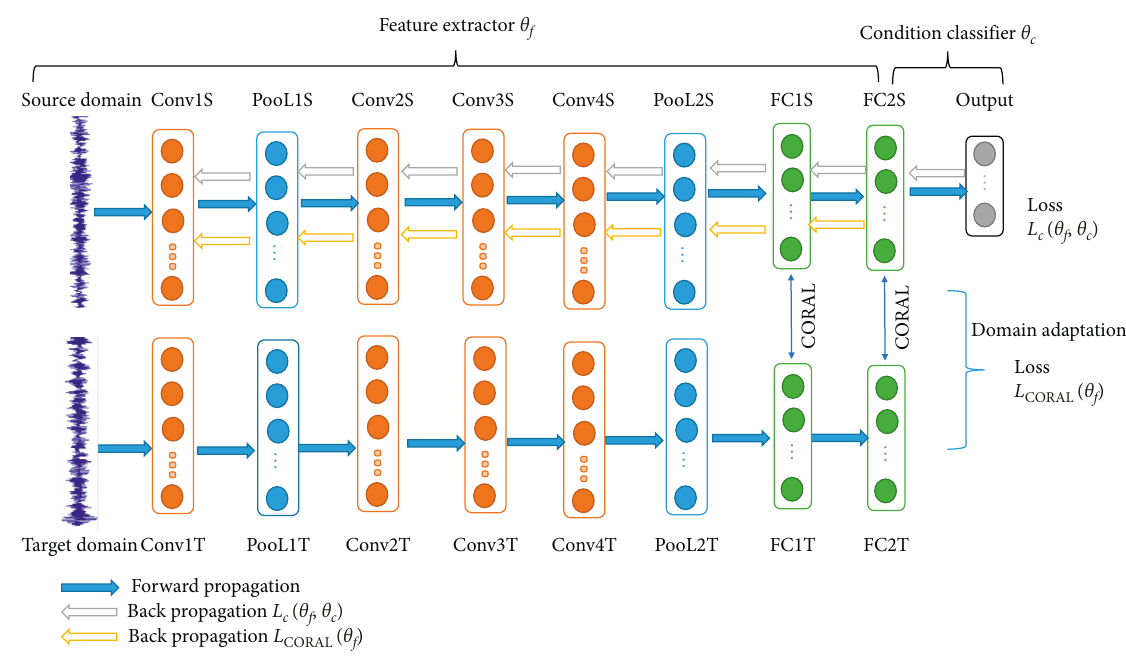
Figure 2: The condition classifier framework based on CNN. Table 1: Structure and parameters of